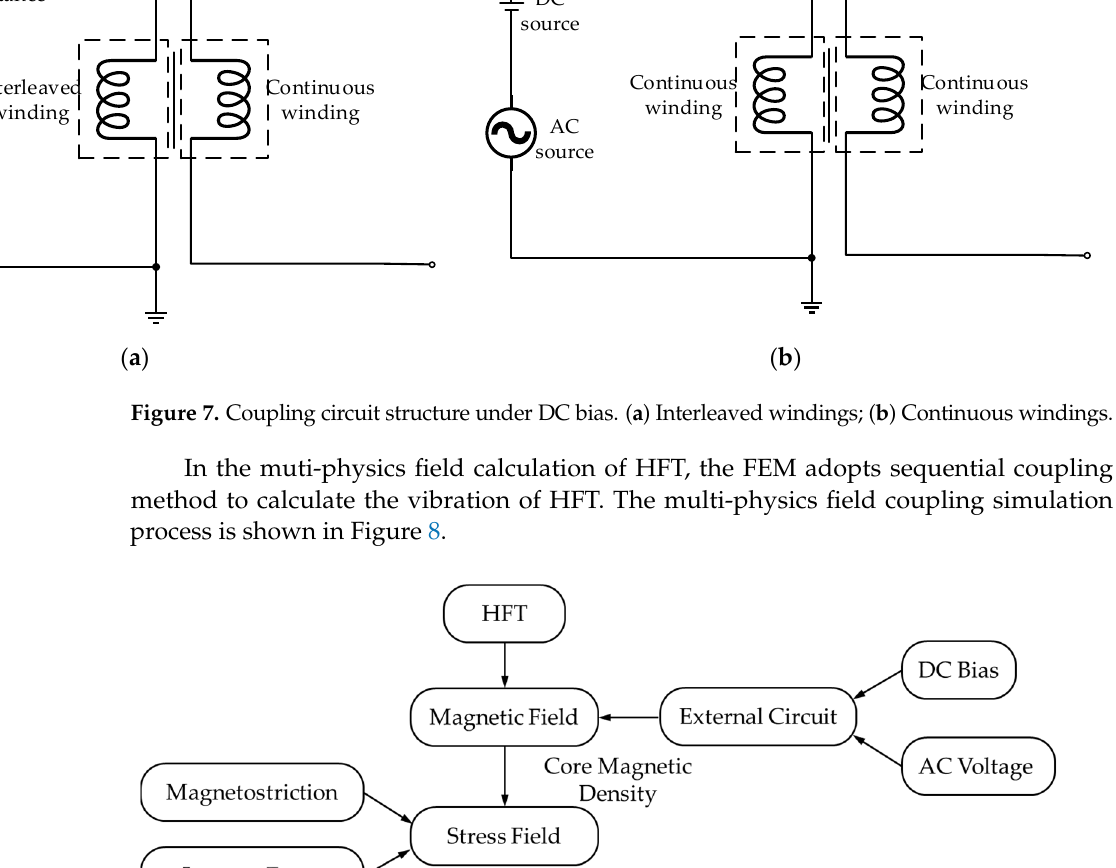
( b ) Figure 9. Schematic diagram of excitation current under di ff erent DC bias coe ffi cients. ( a ) Inter- leaved windings; ( b ) Continuous windings. Both HFT models mentioned above are excited by voltage source. The excitation cur- rent is obtained by simulation. Interleaved windings are wound together with two wires, and then the taps are welded. Compared with continuous winding, the inter-turn connec- tion of interleaved winding is more complicated. Interleaved winding adopts wire trans- position. Therefore, the copper consumption of winding is more than that of continuous winding. Under the no-load condition without DC bias, the excitation current is slightly smaller. With the increase in DC bias component, the positive peak value of excitation current increases gradually, and the negative peak value decreases gradually. When the DC bias coe ffi cient H dc increases to 0.6, the positive peak value of the continuous winding excitation current is 0.55 A, about four times of the peak value of rated no-load current. In addition, the positive peak value of the interleaved winding excitation current is 0.46 A, about 3.5 times that of the peak value of rated no-load current. It is slightly less than the growth ratio of continuous winding, and the same rule is also true under other DC bias coe ffi cients. It can be seen that the interleaved winding can suppress the increase in cur- rent more than continuous winding, thereby suppressing saturation of the iron core.